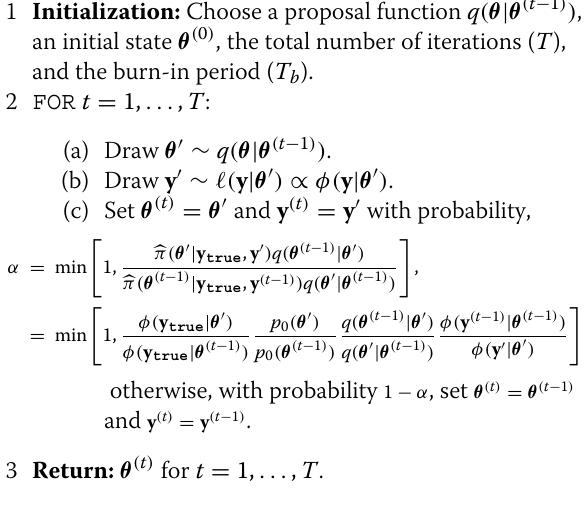
Algorithm 30 Single Variable Exchange (SVE)